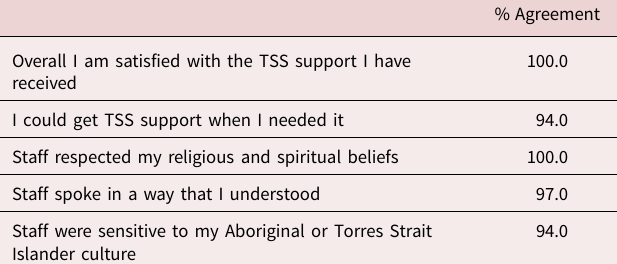
Table 3. Primary students service impact ( n =36)